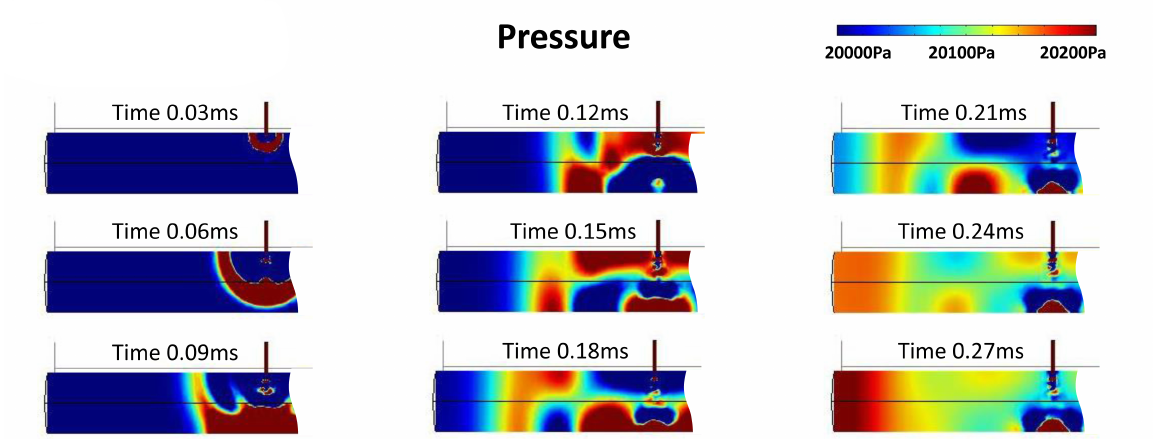
Figure 3. Computational fluid dynamics analysis of negative pressure